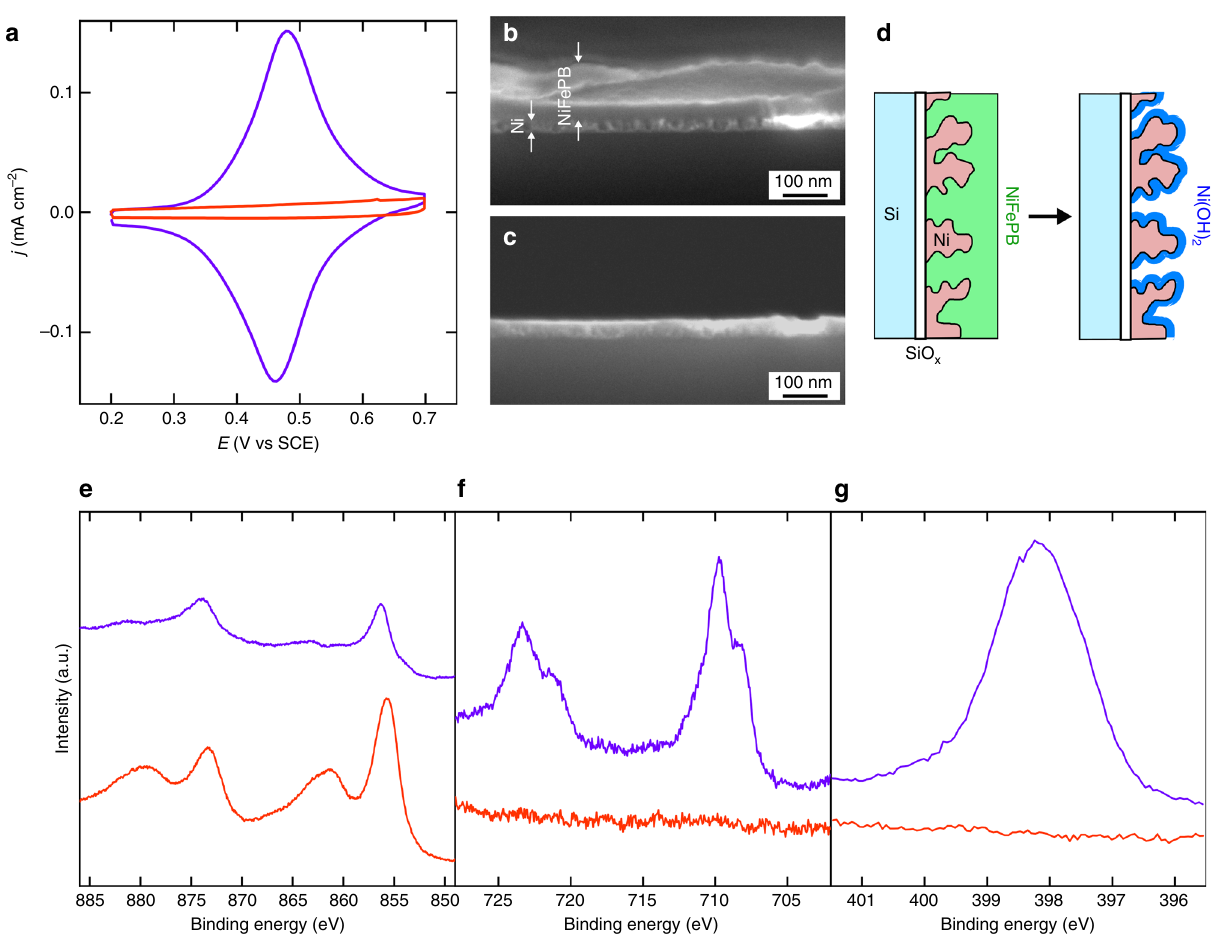
Fig. 5 Characterization of the UOR-active phase. a CVs in 1 M KCl of p + -Si/SiO x /Ni/NiFePB − 75cy at 10 mV s − 1 in the dark (purple) after preparation and (red) after UOR. b , c Cross-section SEM images of p + -Si/SiO x /Ni/NiFePB- 75cy b after preparation and c after UOR. d Scheme showing the changes occurring at a Si/SiO x /Ni/NiFePB surface during UOR. e – g XPS spectra showing e Ni 2p, f Fe 2p, and g N 1 s regions; for p + -Si/SiO x /Ni/NiFePB -75cy (purple) after preparation and (red) after